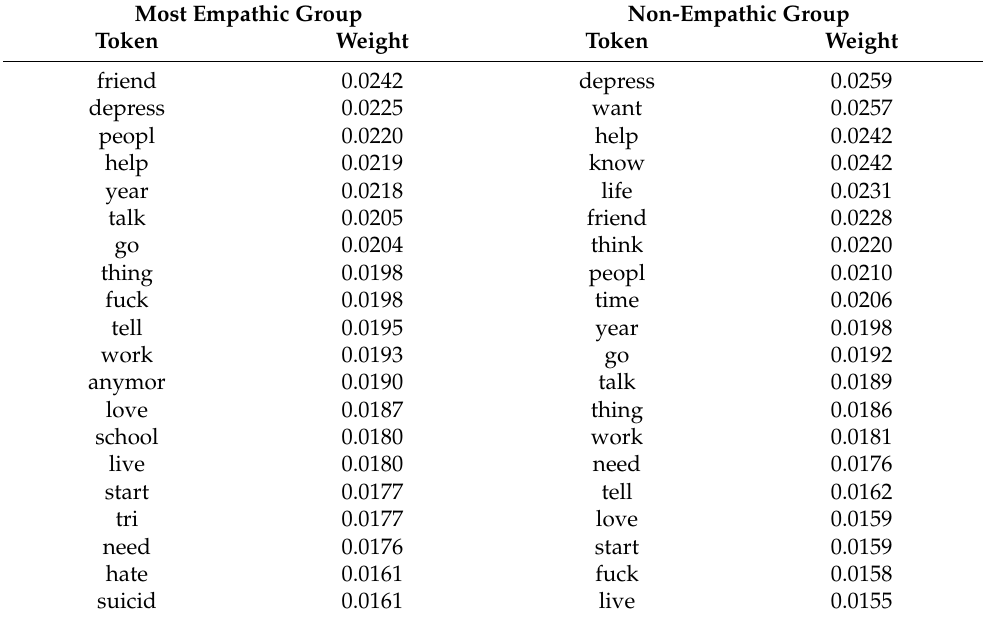
Table 6. Top 20 tokens with highest TF-IDF weight in “most empathic group” and “non-empathic group”. Most Empathic Group Non-Empathic